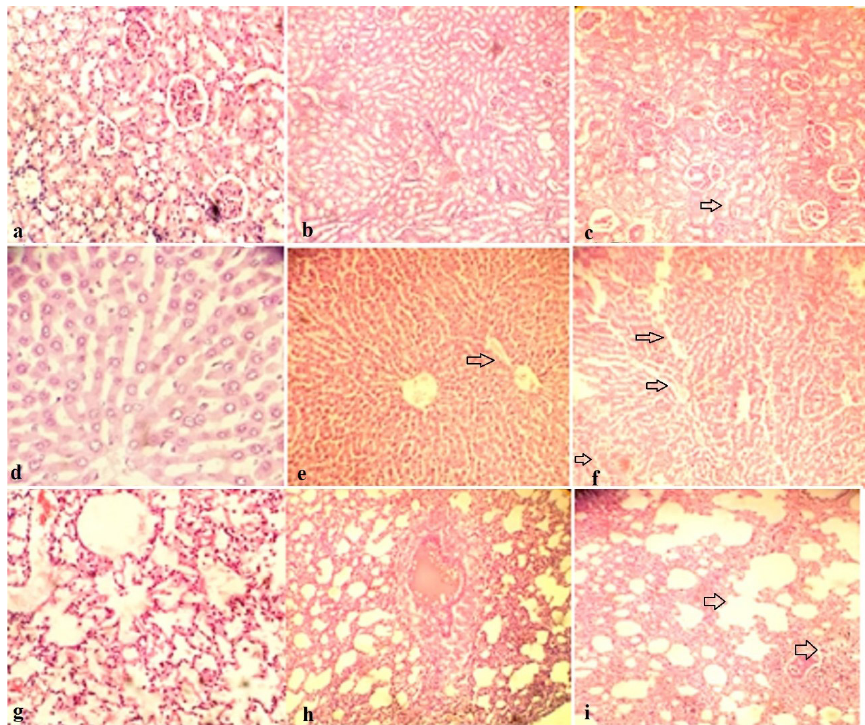
Figure 4. Histopathological pictures of rats exposed to single oral dose of 2000 mg/kg of polyherbal formulations PH 1 and PH 2 at 40X magnification Kidney sections of rats are shown in (a) Control (b) PH 2 that exhibited normal kidney histology and (c) PH 1 that presented mild vascular congestion. Liver sections of rats are shown in (d) Control (e) PH 2 that presented dilated central vein and (f) PH 1 that presented damaged liver architecture, dilated central vein and infiltration of inflammatory cells. Lungs sections of rats are shown in (g) Control (h) PH 2 that presented vascular congestion and sparse lymphocytic aggregates and (i) PH 1 that exhibited lymphocyte aggregation and alveolar distension and